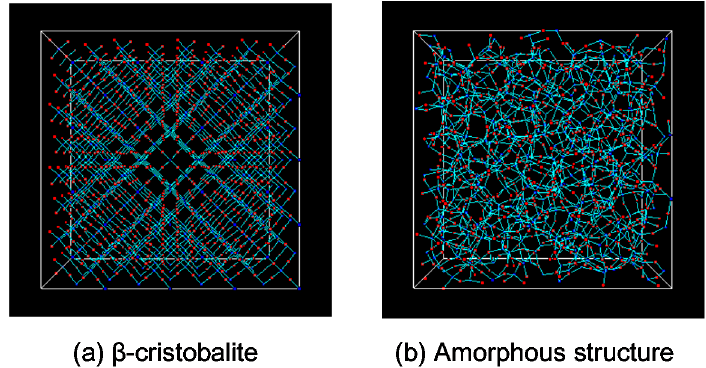
Figure 1. Examples of snapshots of silica structures with a density of 2.2 g / mL; ( a ) β -cristobalite, ( b ) amorphous silica structure.